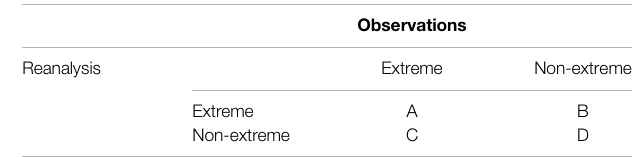
TABLE 2 | 2 × 2 contingency